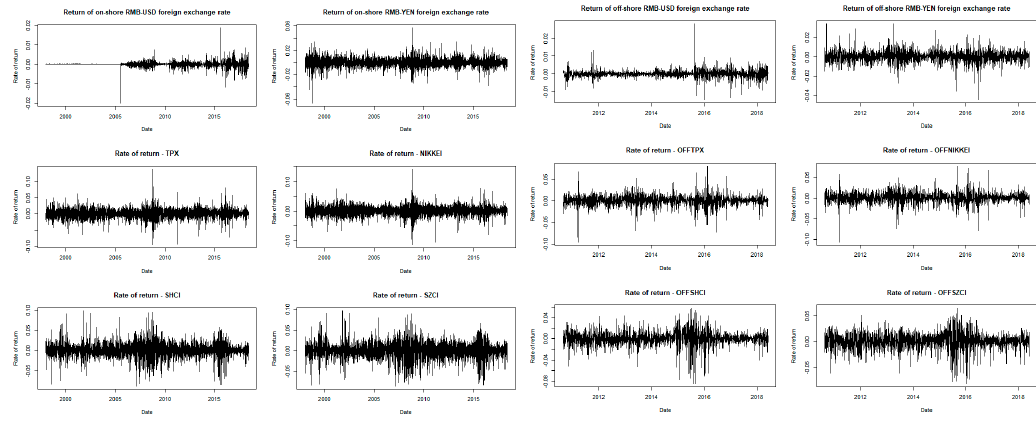
Figure 1. Daily stock returns and exchange rate changes.